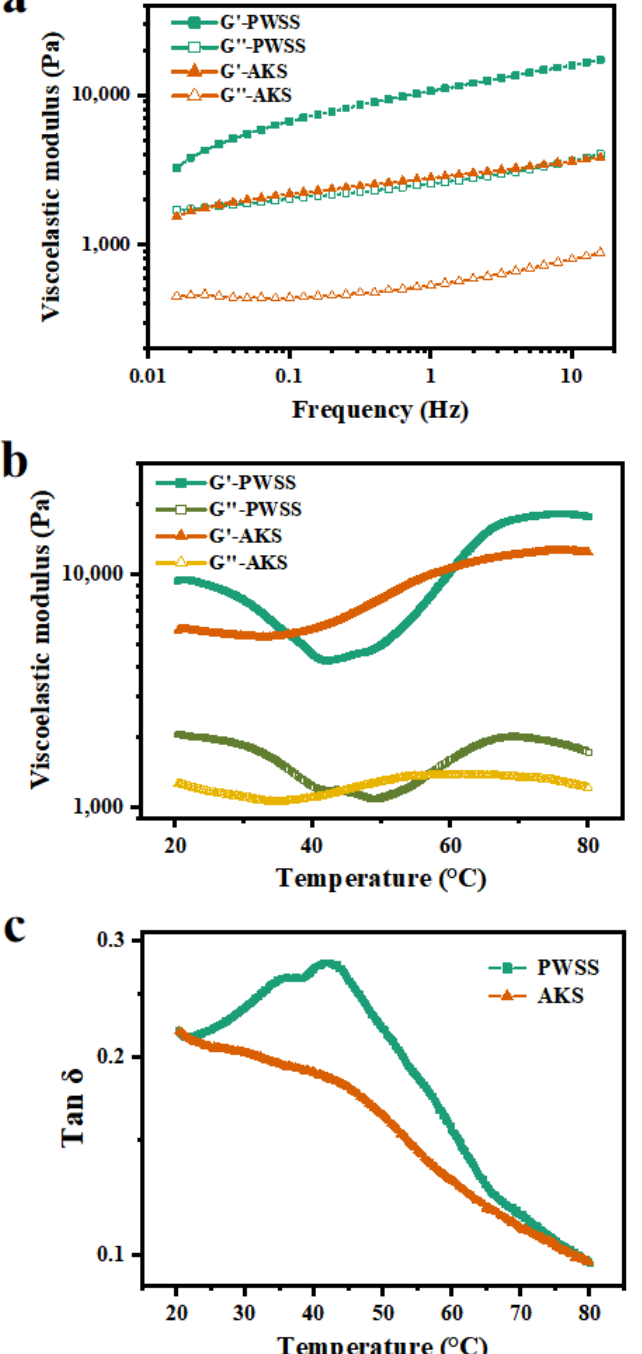
Figure 2. Viscoelastic properties of Antarctic krill and Pacific white shrimp surimi during the heat- induced gelation process: ( a ) Frequency sweep, ( b ) temperature sweep, and ( c ) tan δ . PWSS, Pacific white shrimp surimi; and AKS, Antarctic krill surimi.